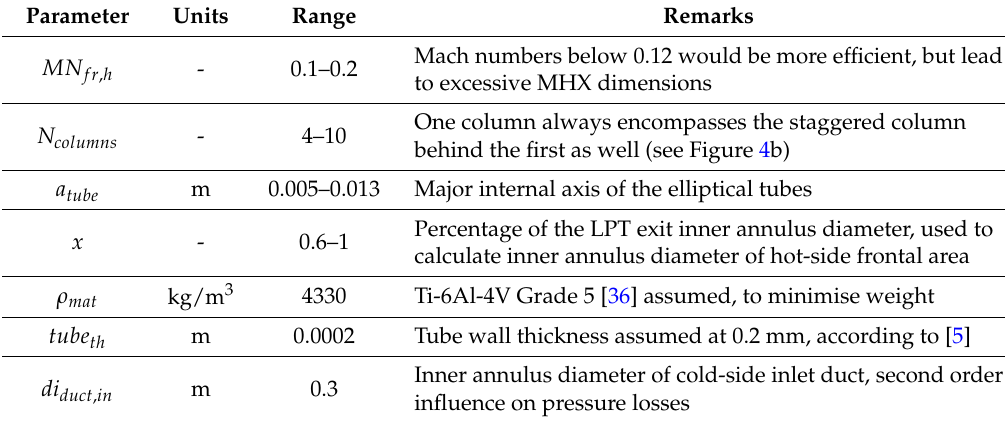
Table 4. Main heat exchanger (MHX) design parameters.